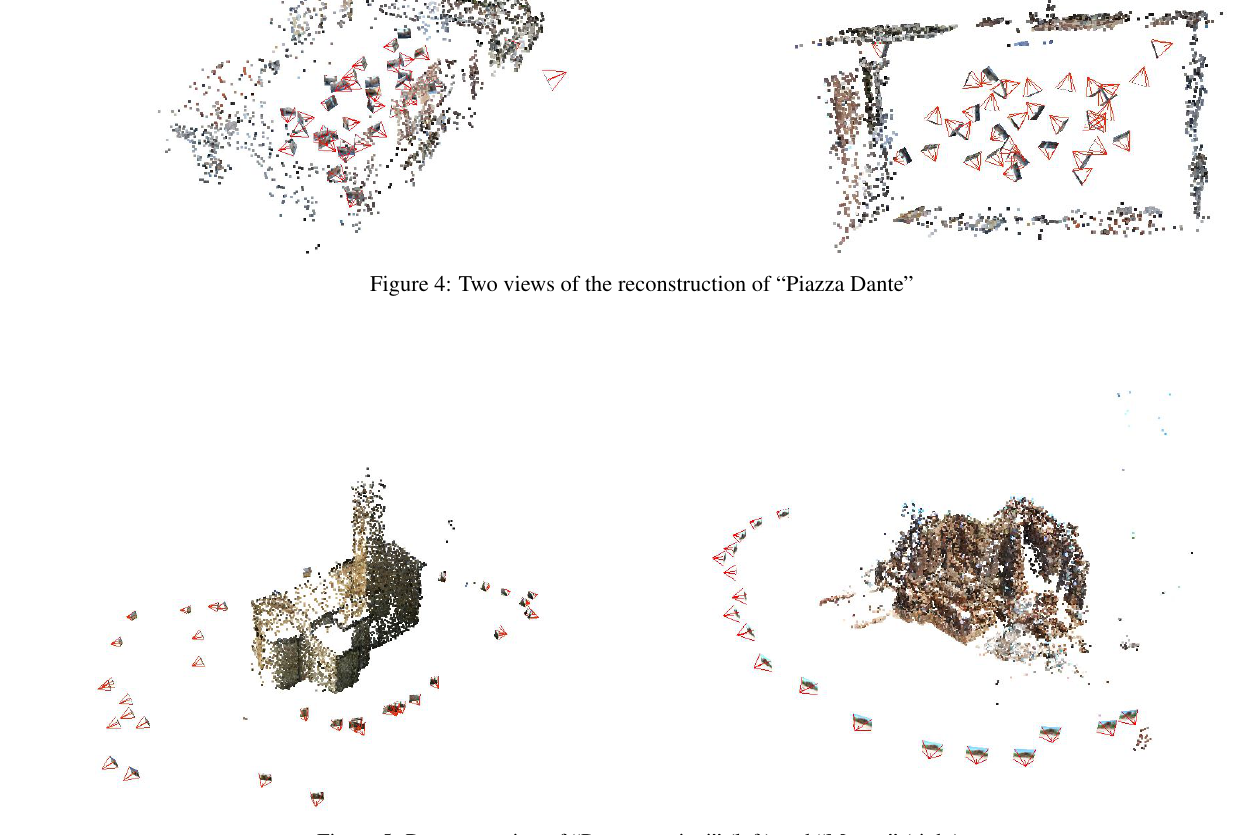
Figure 5: Reconstruction of “Pozzoveggiani” (left) and “Myson” (right)